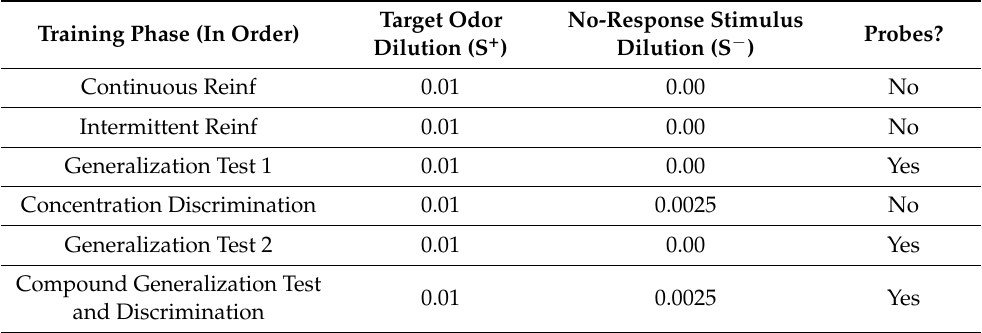
Table 2. Training sessions conducted. The target stimulus (alerts reinforced) and non-target stimulus (no-go response reinforced) of the trials are shown. The training is shown in the order in which it was conducted (top to